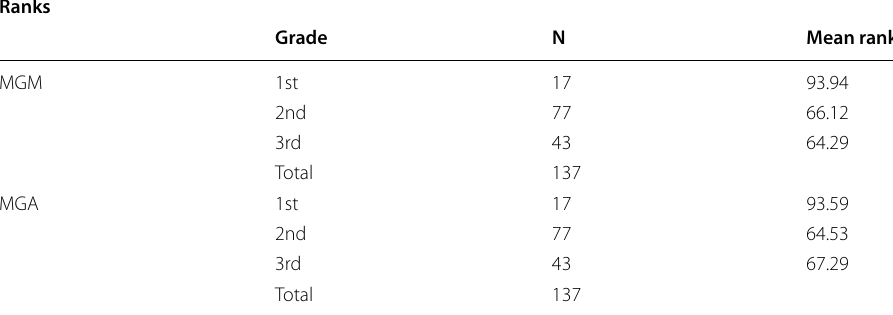
Table 7 Test statistics [Kruskal Wallis Test—Grouping Variable: grade] Ranks